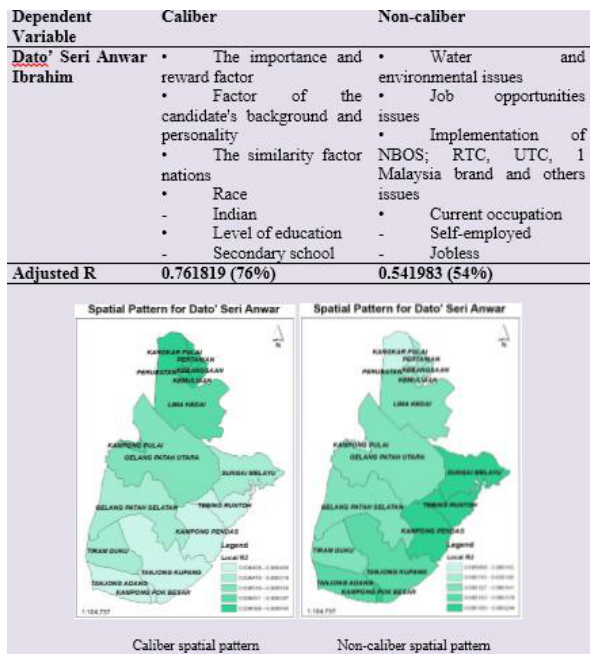
Figure 22. Explanatory variable for Dato‟ Seri Anwar